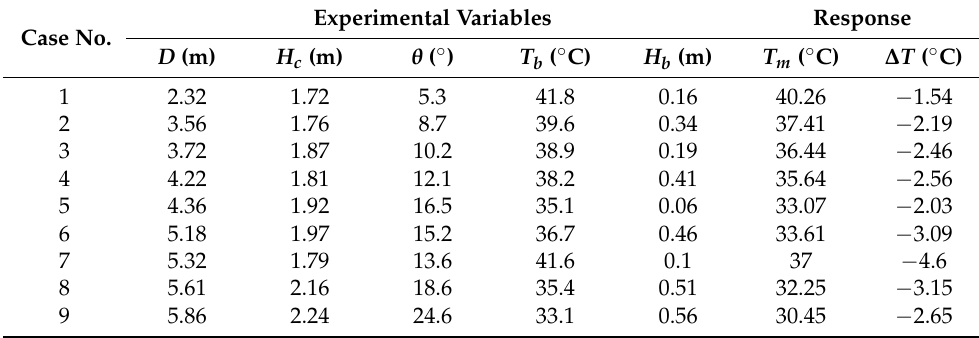
Table 3. Levels of investigated parameters in the cases for testing the RSM model. Experimental Variables Response Case No.